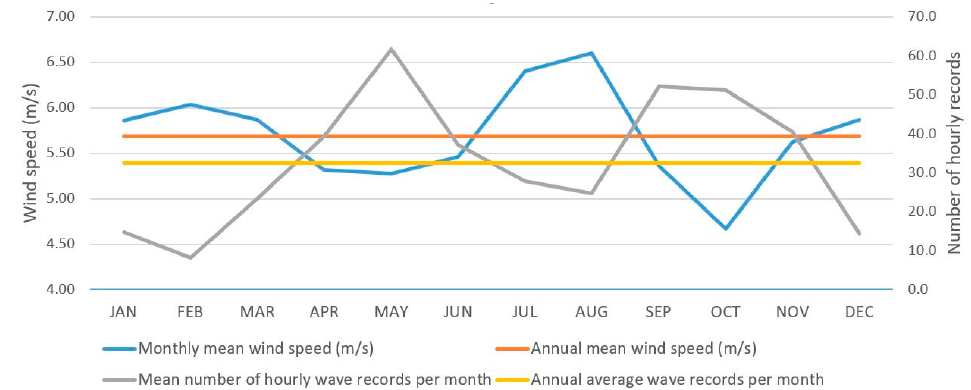
Figure 9. Monthly mean wind speed vs. monthly swell records for 2009–2020.